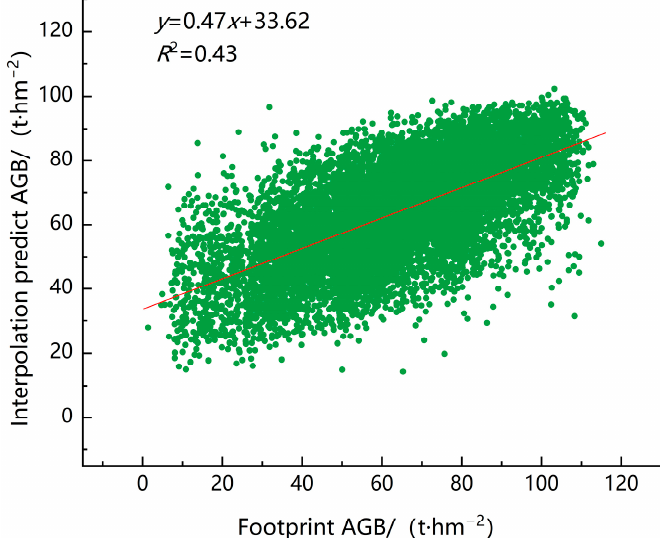
Figure 10. Interpolation accuracy validation scatter